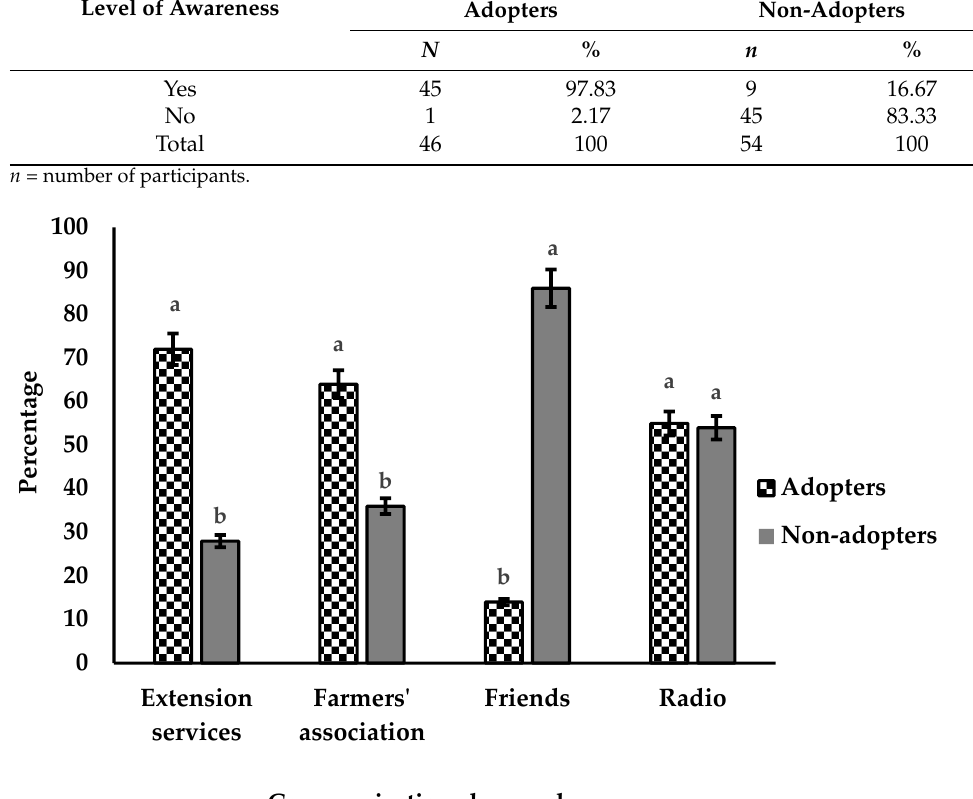
Figure 2. Communication channels available to the SHF.